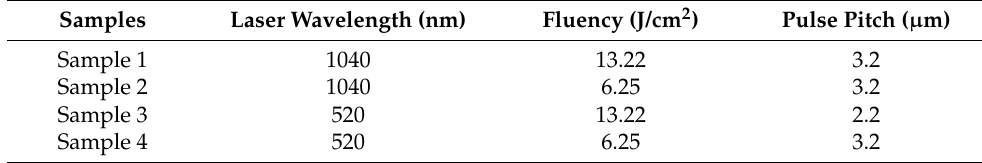
Table 1. Laser processing